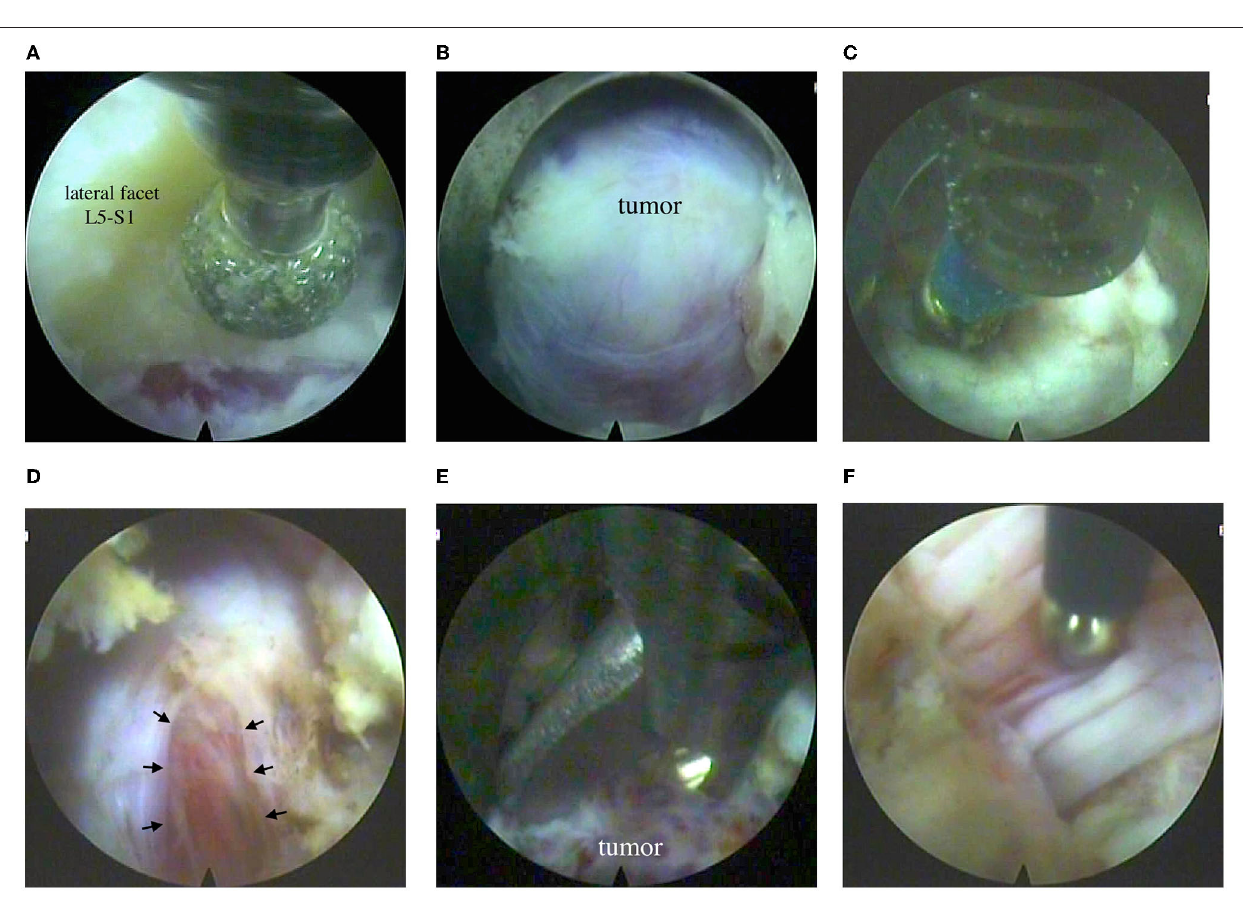
FIGURE 3 | Endoscopic step of the surgery: (A) partial resection of the L5-S1 lateral facet on the left with a burr; (B) view of the tumor in the intervertebral foramen; (C) bipolar electrocoagulation of the nerve sheath; (D) incision of the nerve sheath (see arrow); (E) removal of the tumor with forceps; (F) monopolar stimulation of the nerve bundles with a modified elongated probe (based on Medtronic probe,